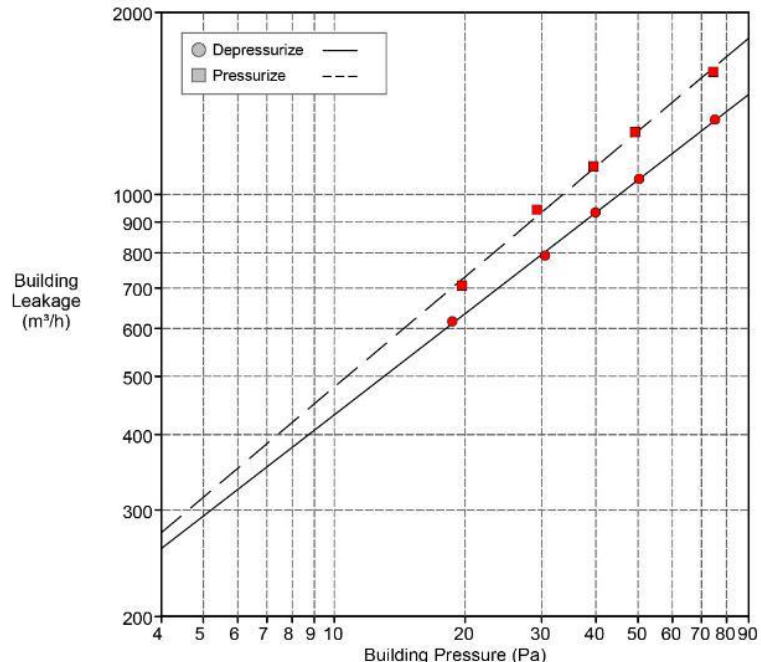
Figure 6. Example of pressurization and depressurization test graph.